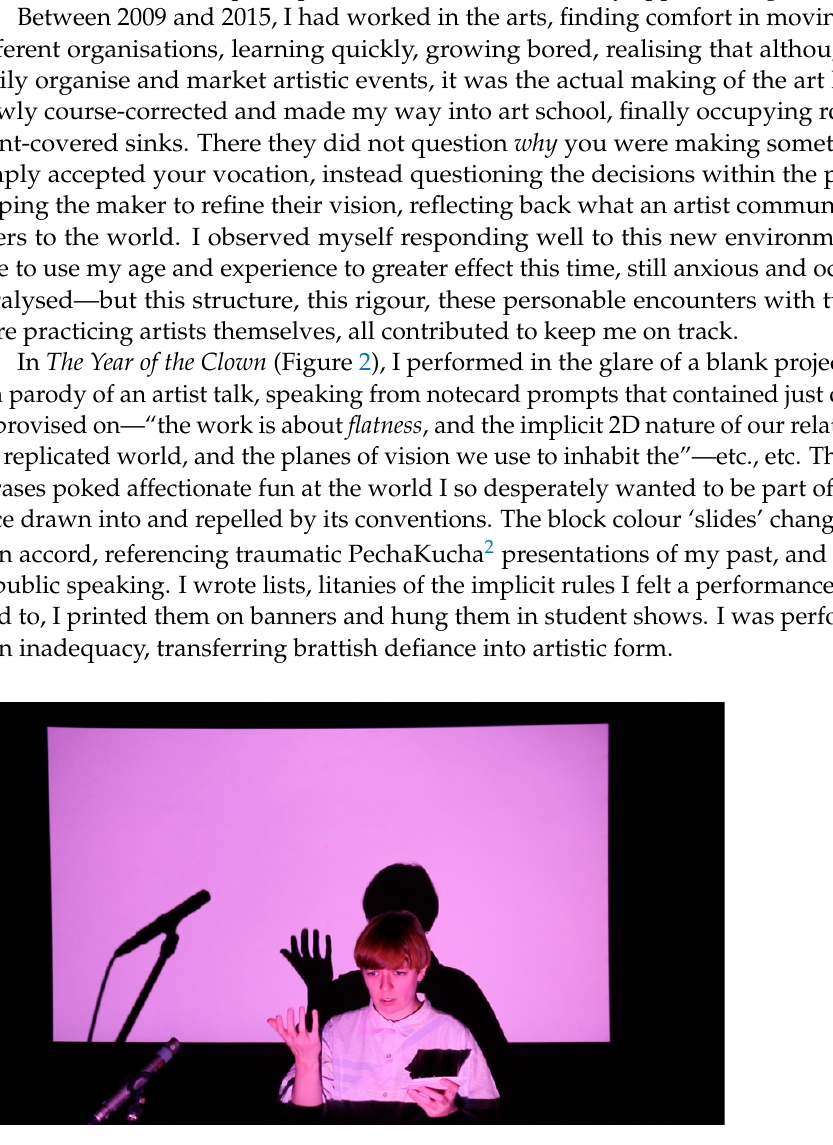
Figure 2. Denton, Grace. The Year of the Clown , performance with digital projector and note cards. Part of Playing Myself , in response to The Bodyssey Odyssey by Pester & Rossi, BALTIC 39, December